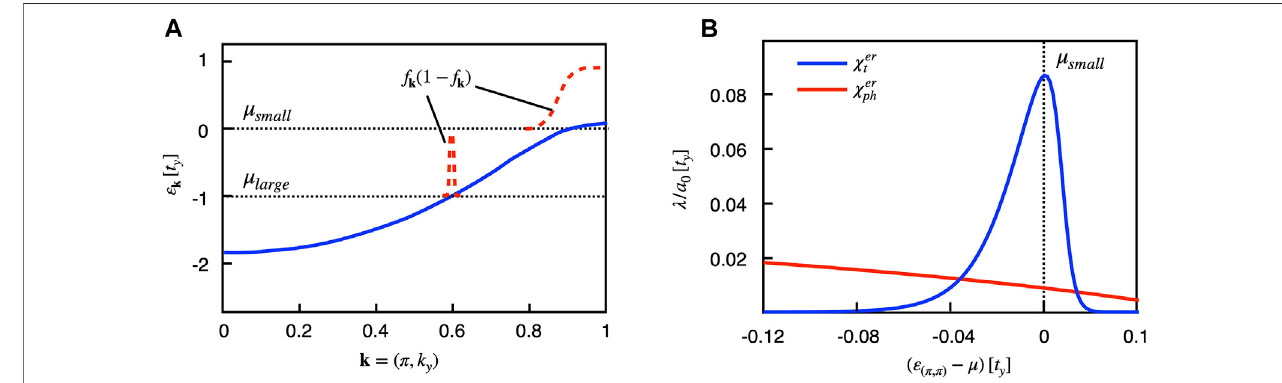
FIGURE4| Theoreticalconsiderationoftheelastoresisitivity. (A) Dispersionofthehole-likebandleadingtoaverysmallholepocketaroundthepoint( π , π )whenthe chemical potential μ small (upper dotted line) is placed near the Lifshitz point. The range of momentum vectors contributing to the elastoresisitivity arising from the Fermi function is schematically shown by the dashed lines. A much larger hole pocket is indicated by a lower value of the chemical potential μ large (lower dotted line). (B) Calculated parts of the elastoresistivity according to Eq. 3 . Around the Lifshitz point μ small the fi rst-order part χ er t dominates the second-order part which is, however, the most important contribution for μ away from the Lifshitz